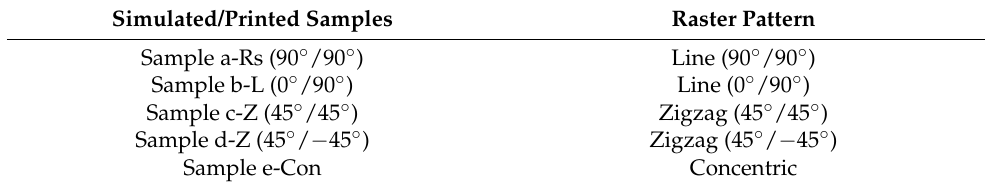
Table 1. Raster patterns considered for the simulation